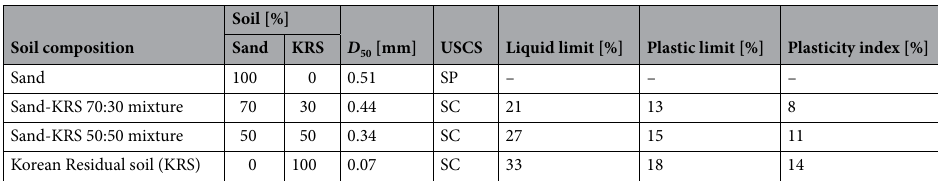
Table 1. Details of soil composition and properties used in this study. USCS Unified soil classification system, SP poorly graded sand, SC clayey sands.